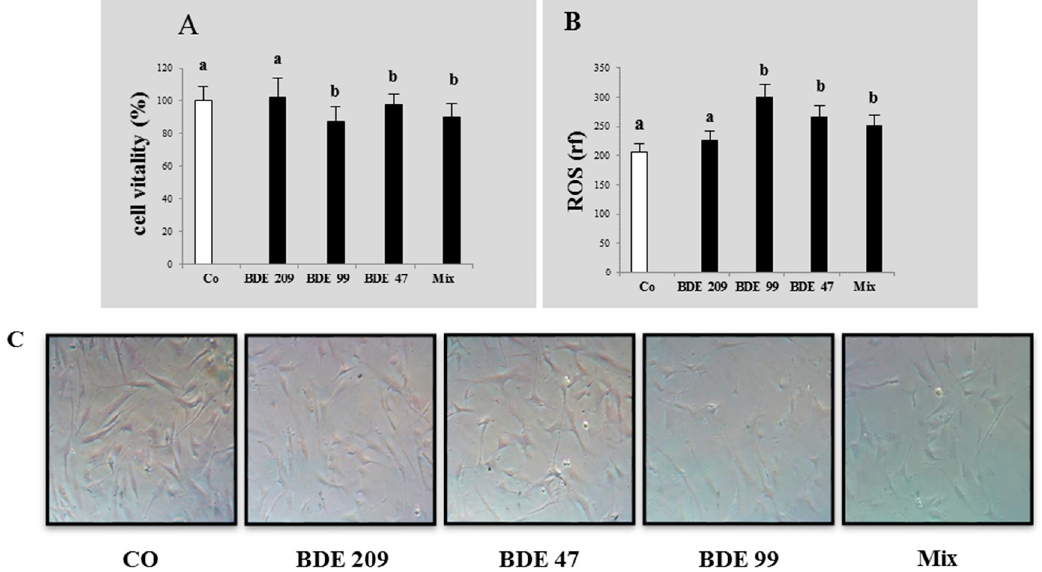
Figure 2. Cytotoxicity and oxidative stress on HS-68 cells exposed for 20 days to 1 µ mol/L BDE 209, 99, 47 and MIX: ( A ) vitality percentage (vs. control); ( B ) intracellular ROS production (expressed as relative fluorescence). Bars represent the mean ± SEM ( n = 6). Different superscript letters represent statistically significant differences (ANOVA; p ≤ 0.05) vs. control. ( C ) HS-68 cells after 20 days of treatment (phase contrast microscopy at 20 × magnification).